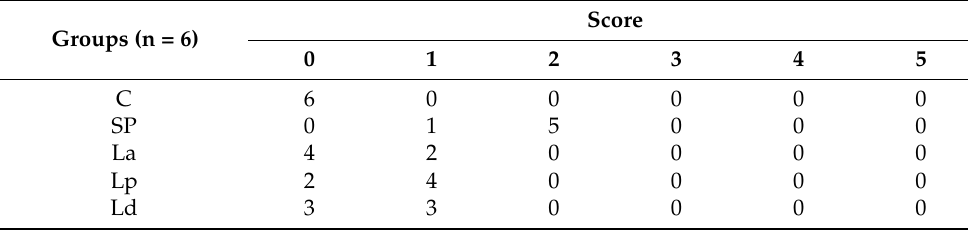
Figure 2. Effects of Lactobacillus on body weight gain. Table 2. Sensitization scores in different groups of